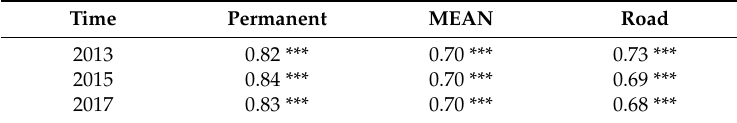
Table 5. Pearson correlation coe ffi cients between the GDP and other covariates.